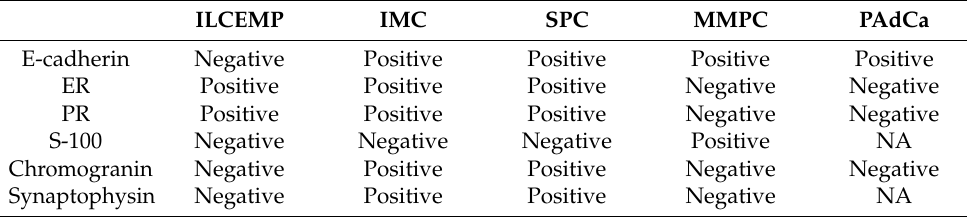
Table 5. Immunohistochemical characteristics of invasive lobular carcinoma with extracellular mucin production and its differential diagnoses.